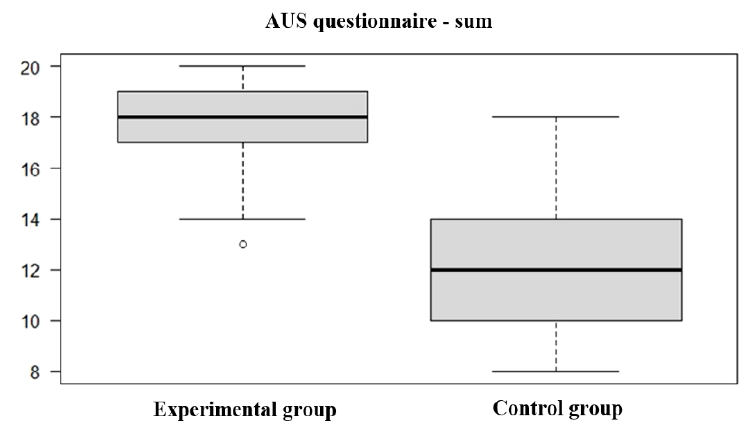
Figure 3. Hypothesis 2 – AUS questionnaire